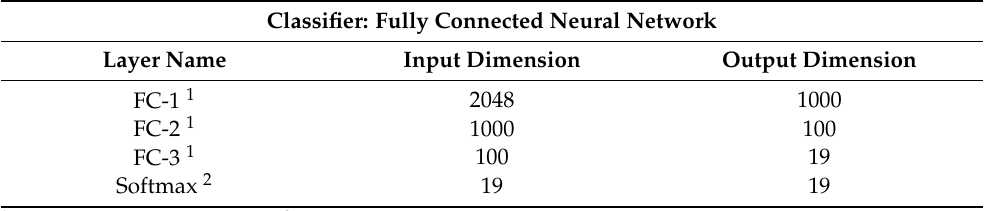
Table 7. The architecture of a fully connected network in our color identification